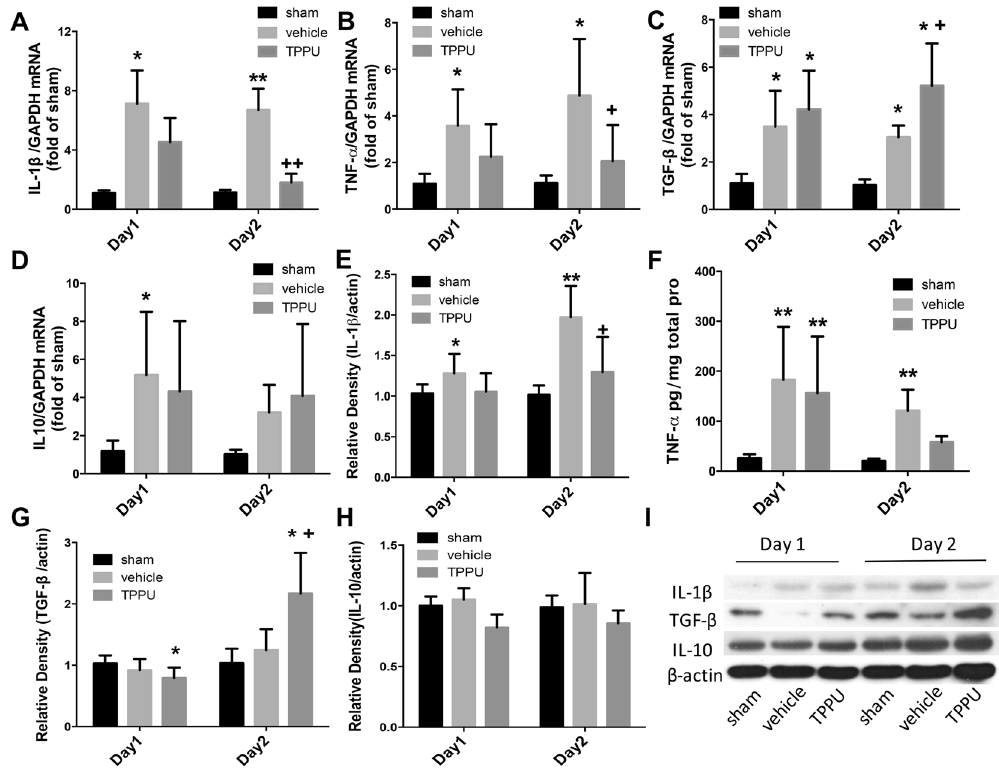
Figure 6. TPPU modifies inflammatory cytokine expression at 1 and 2 d after surgery. ( A – D ) Real-time PCR was used to analyze mRNA expression of inflammatory factors. Logarithmically transformed data were subjected to ANOVA and the Holm-Sidak procedure (means ± SD). ( E – G , I ) Protein levels of IL-1 β , IL-10, and TNF- β were measured by Western blot. IL-1 β , TGF- β and β -actin bands were stripped and cropped from the same gel and were developed with the same exposure. To avoid overlapping bands, IL-10 was run on a separate gel from the same sample. Images of the full gels are shown in Supplementary Figure S2. ( H ) TNF- α expression was analyzed by ELISA. Data were analyzed with Kruskal-Wallis analysis of ranks, which, when significant, was followed by the Mann-Whitney test for pairwise comparisons. For ( A – H) , n = 6 rats per group; * p < 0.05, ** p < 0.01 vs. sham group; + p < 0.05, ++ p < 0.01 vs. vehicle